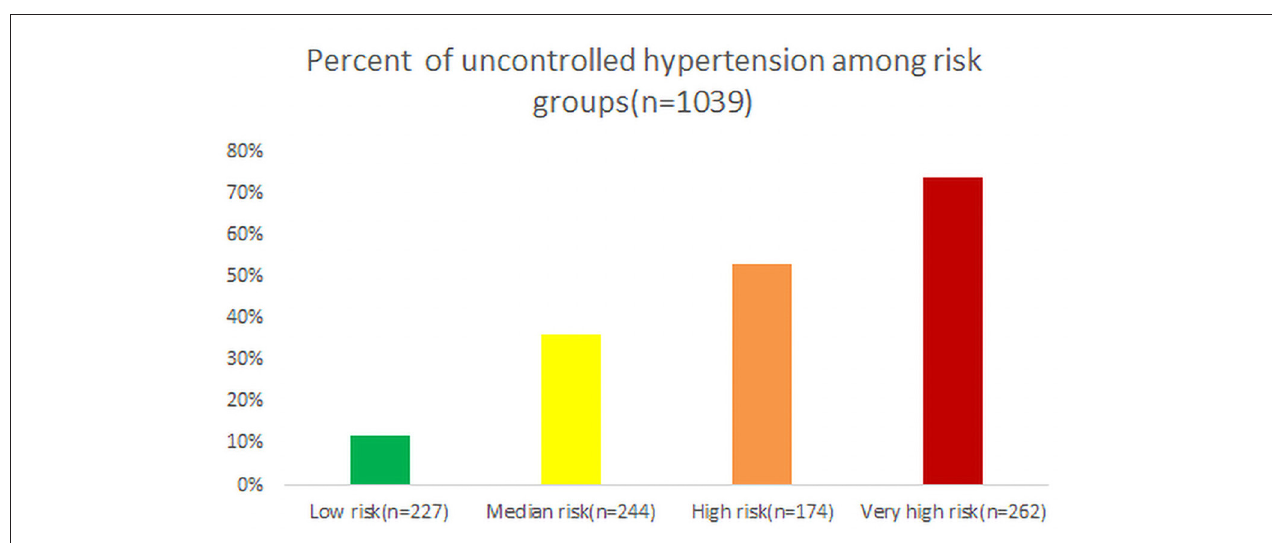
FIGURE 3 | Uncontrolled hypertension with different risk